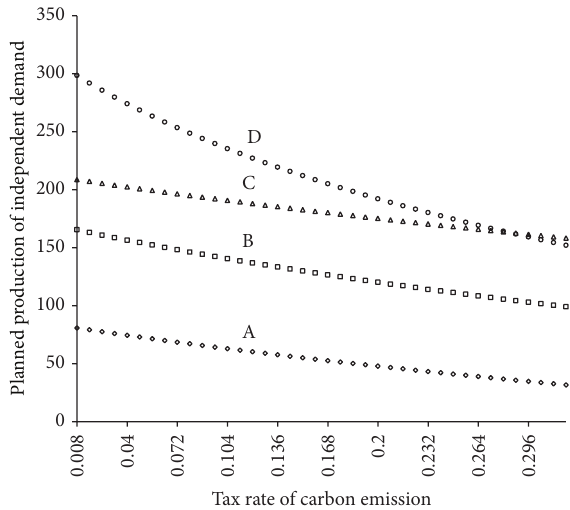
Figure 6: Effect of carbon tax of per unit carbon emissions on planned production of independent demand.